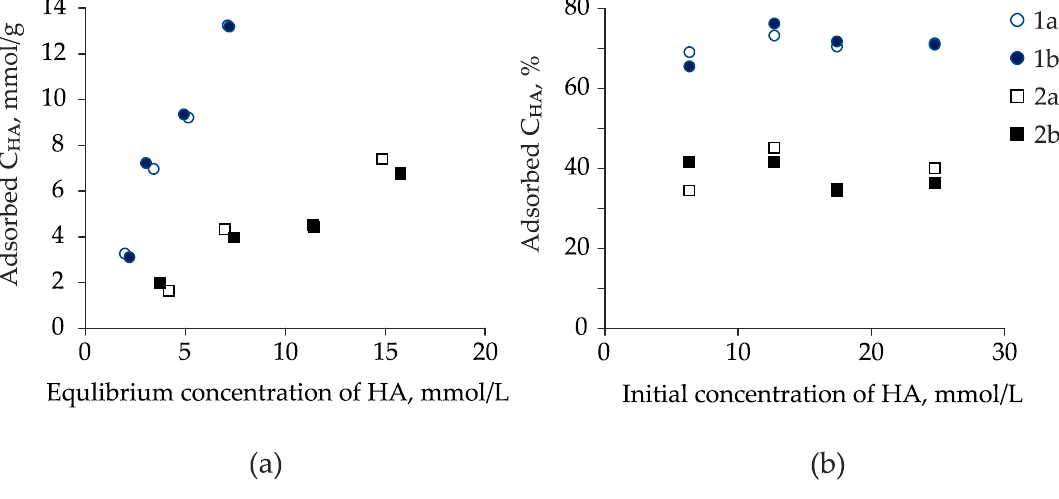
Figure 8. The dependence of the sorption of Cu(II) in mmol/g ( a ) and % ( b ) on Na-bentonite (1) and Al 13 -bentonite (2). Empty and filled icons (a,b)—repetitions of the same experiment.